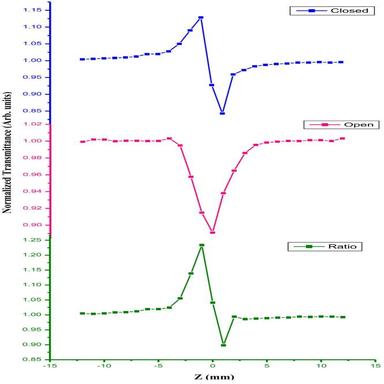
Closed-aperture, open-aperture and ratio of closed to open-aperture z-scan of the (E)-N- -(3-ethoxy-4-hydroxybenzylidene)−4-fluorobenzohydrazide crystal.